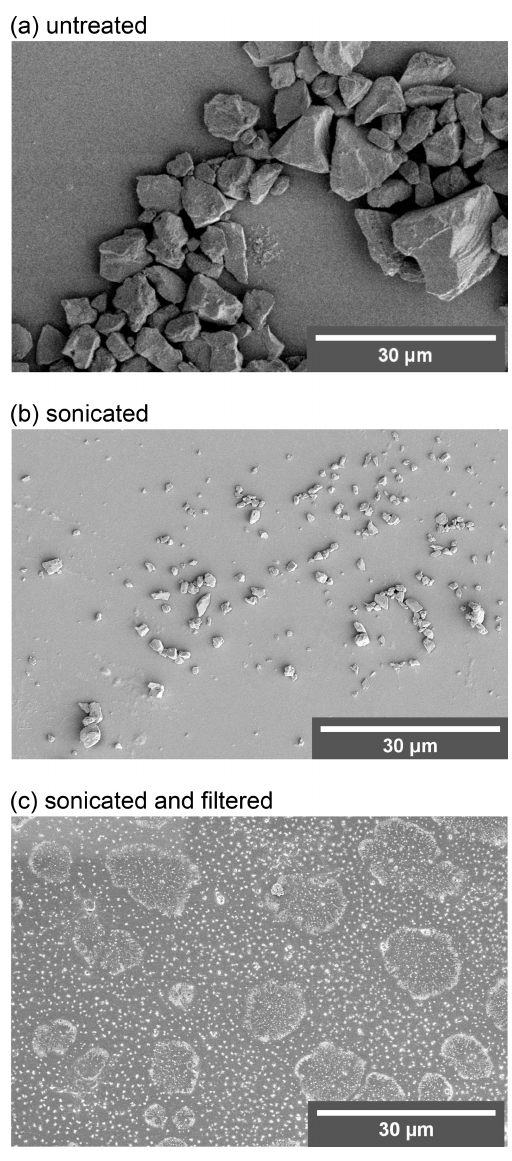
Figure A1. Scanning electron microscopy images of microcline that was (a) untreated, (b) sonicated with 8 × 30s pulses in an ultra- sonic VialTweeter, and (c) sonicated using the same procedure as panel (b) but additionally filtered (0.45µm syringe filter).